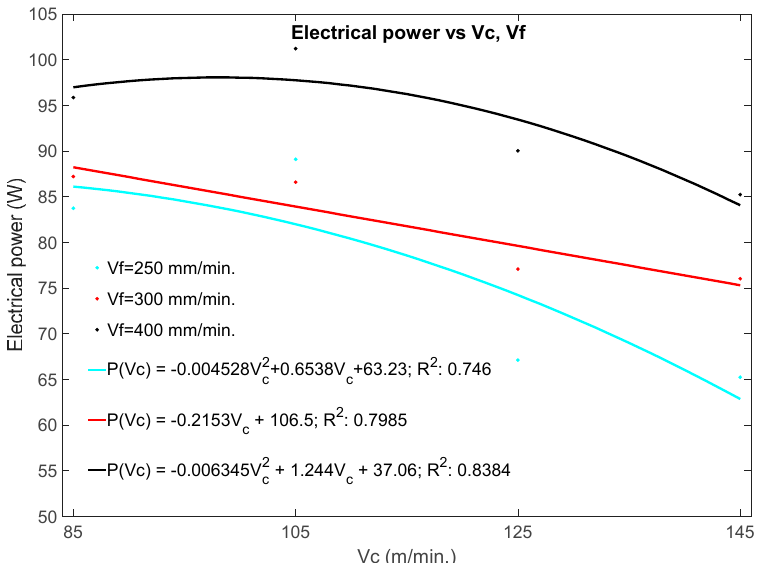
Figure 5. E ff ects of cutting speed and feed rate on the torque ( T ). Figure 5. Effects of cutting speed and feed rate on the torque ( T ).